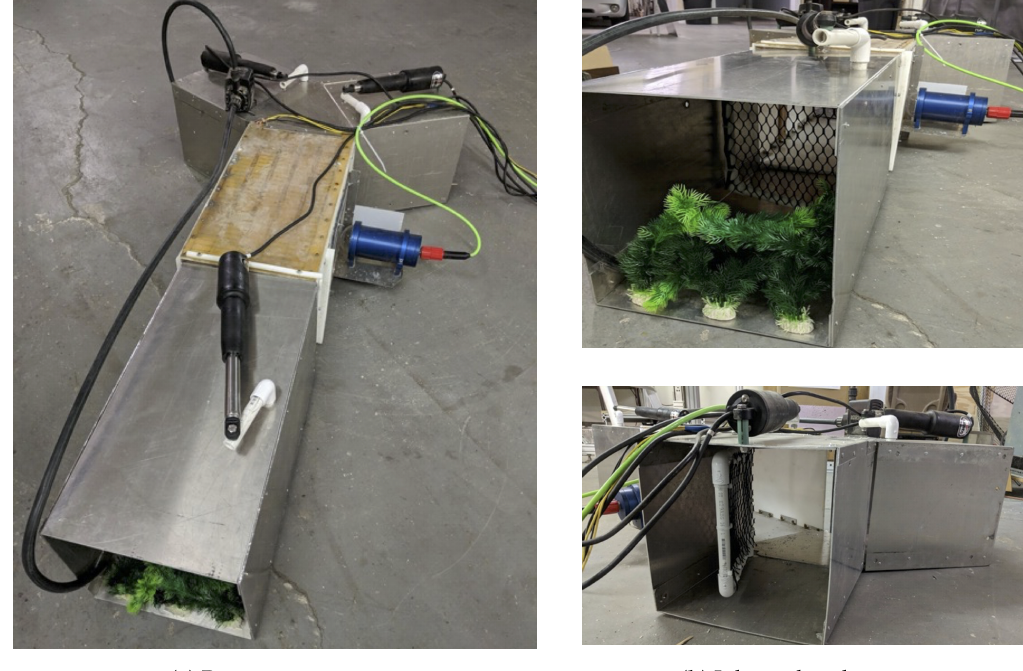
Figure 5. The prototype four-chamber